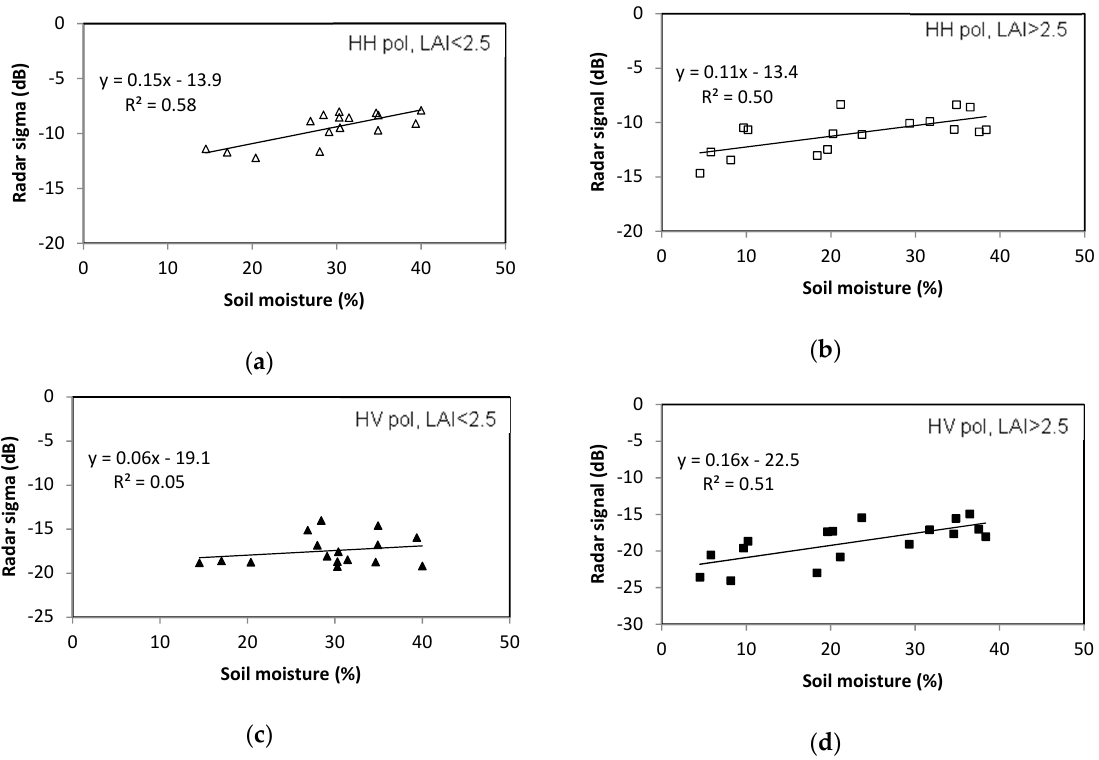
Figure 6. PALSAR radar data as a function of soil moisture for turmeric cover: ( a ) HH polarization,